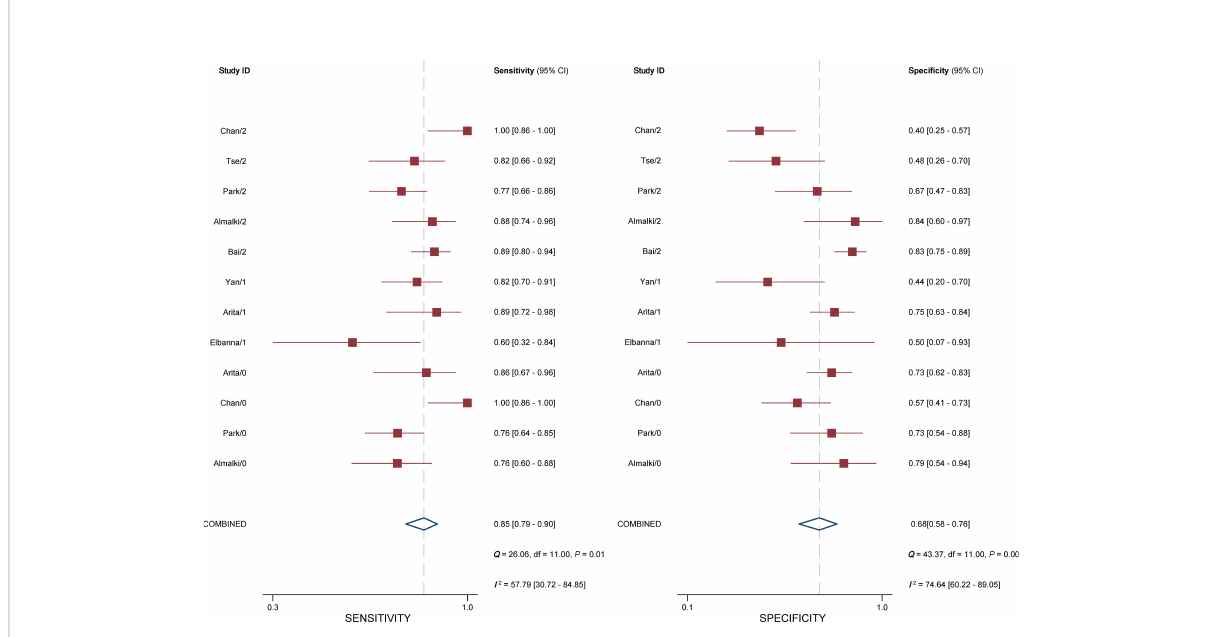
FIGURE 3 Coupled forest plot of pooled sensitivity and speci fi city. The numbers are pooled estimates; the 95% CI appears in parentheses. Corresponding heterogeneity statistics are provided in the bottom right corners. Horizontal lines indicate 95% con fi dence